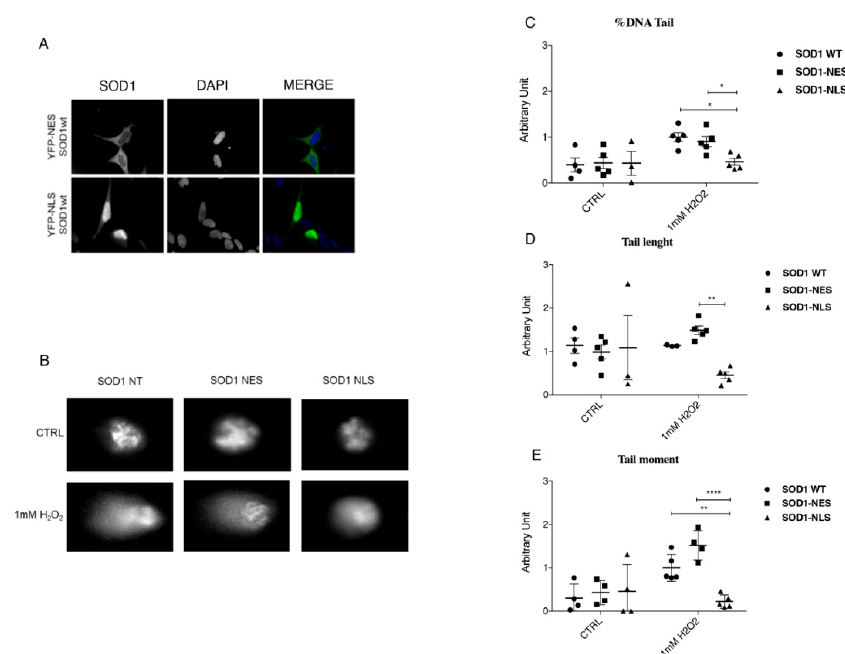
Figure 5. ( A ) Cytoplasmic and nuclear localization of SOD1; chimeric fluorescent-tagged proteins